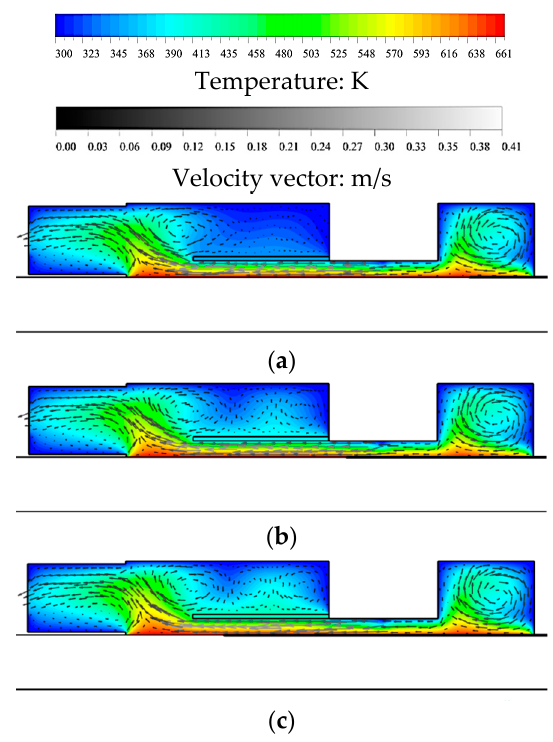
Figure 6. Velocity vector coupled with temperature contour of CdTe growth under different deposition times: ( a ) 60 s; ( b ) 180 s; ( c ) 300 s at a temperature of 668 K.